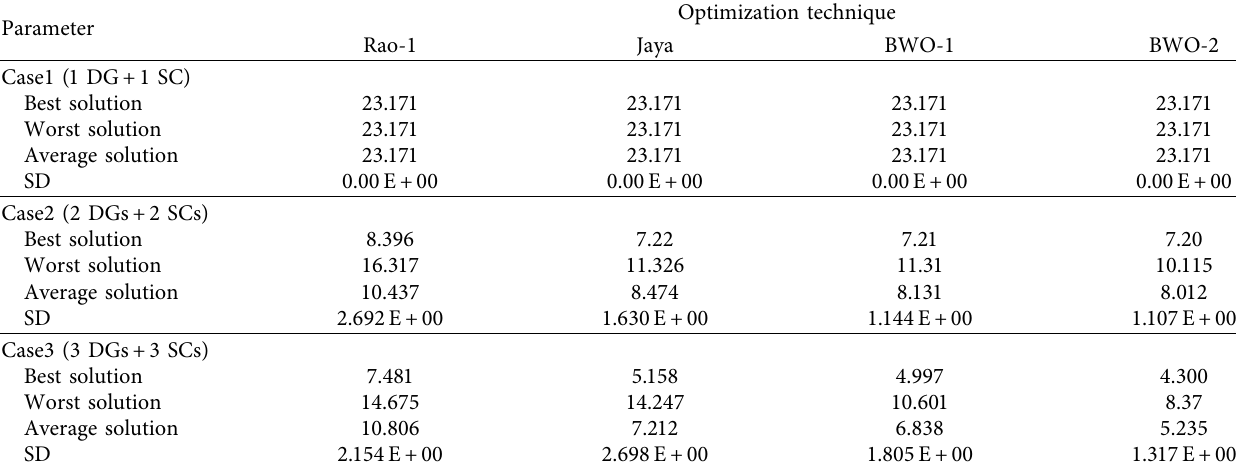
Table 12: Statistical analysis of Rao-1, Jaya, BWO-1, and BWO-2 for 69-bus test system.